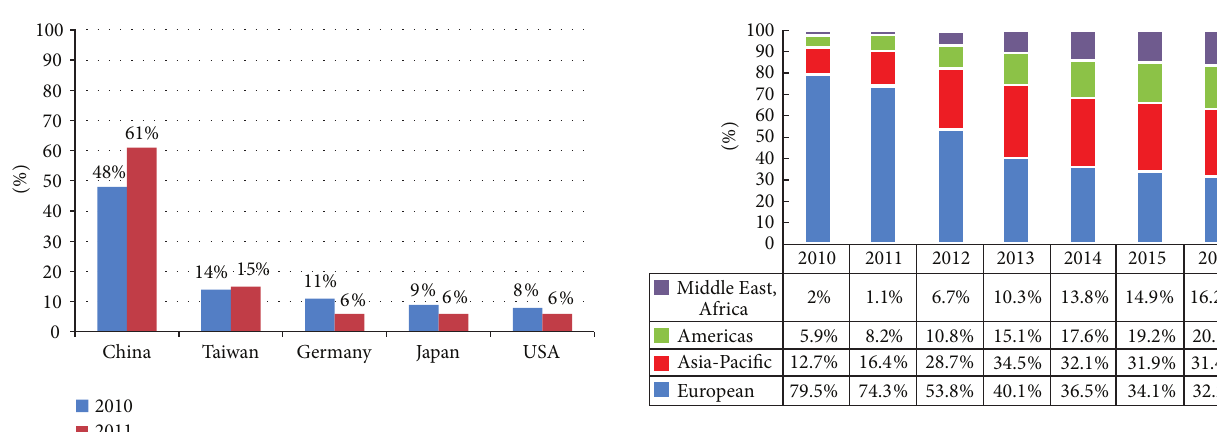
Figure 6: 2010–2016 global solar photovoltaic market (by geo- graphic area). Source: ITRI (2012)